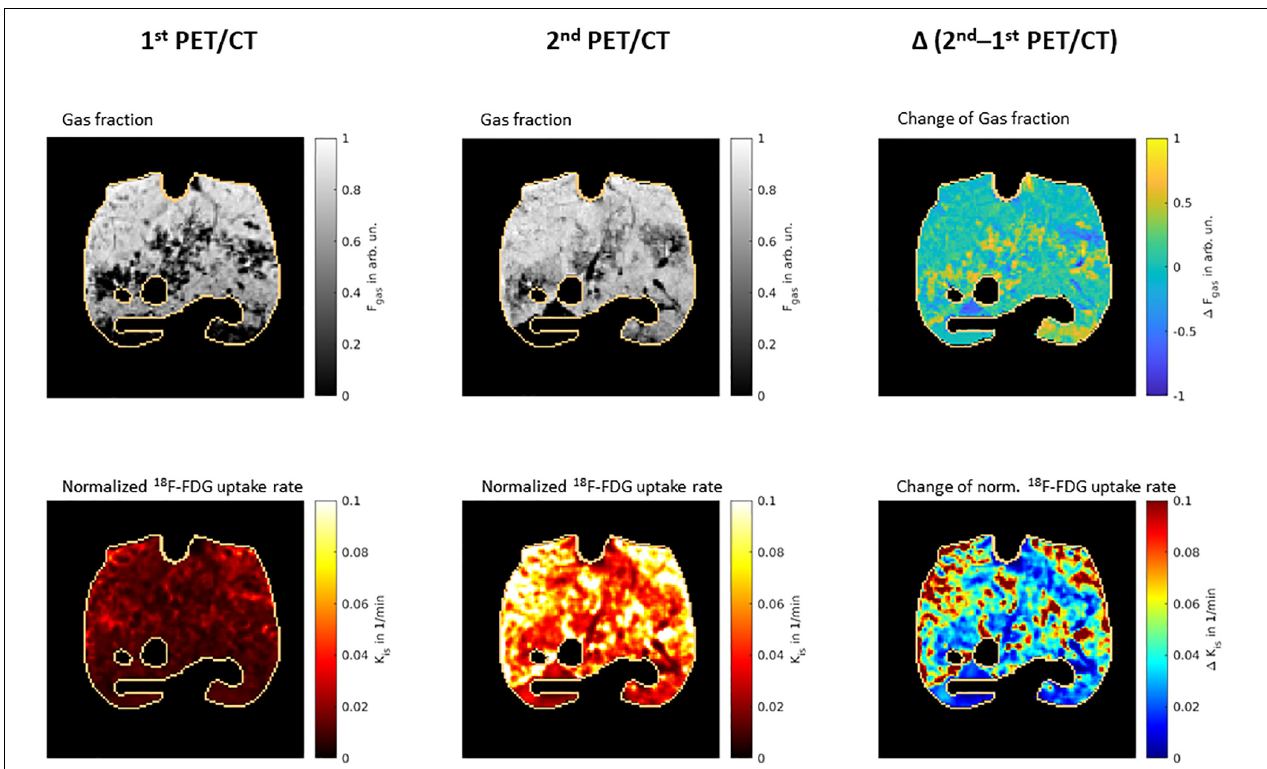
FIGURE 4 | Representative PET/CT scans. Representative PET/CT scans from one representative animal, showing gas fraction (upper row) and normalized 18 F-FDG uptake rate (lower row) from first (left column) and second lung scans (middle column) . The right column shows the difference between second and first scan after co-registration of ACCTs using Elastix Library. The lung masks are outlined in copper color. F gas , gas fraction; arb. un., arbitrary units; 18 F-FDG, 2-deoxy-2-[ 18 F]fluoro- D -glucose; K iS , normalized uptake rate of 2-deoxy-2-[ 18 F]fluoro- D -glucose.